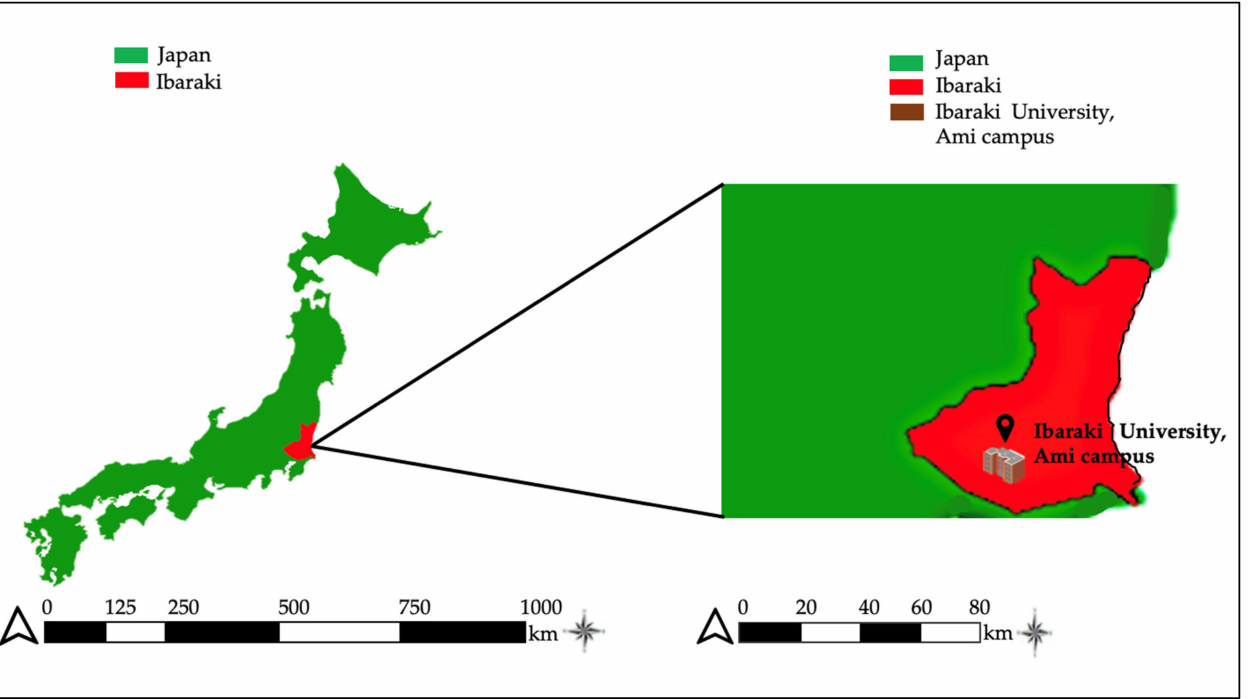
Figure 1. Map of study area: Center for International Field Agriculture Research and Education, Ibaraki University,